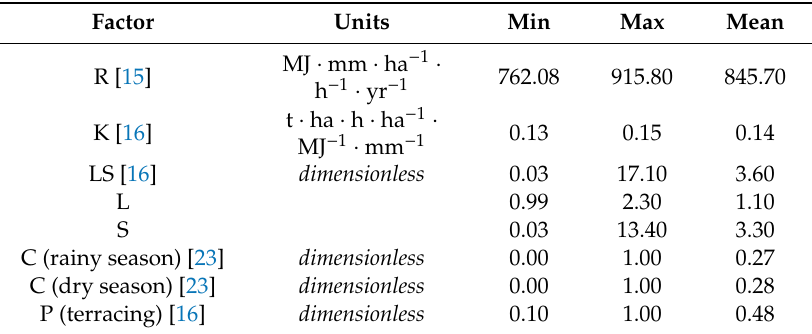
Table 5. Values of the di ff erent (R)USLE